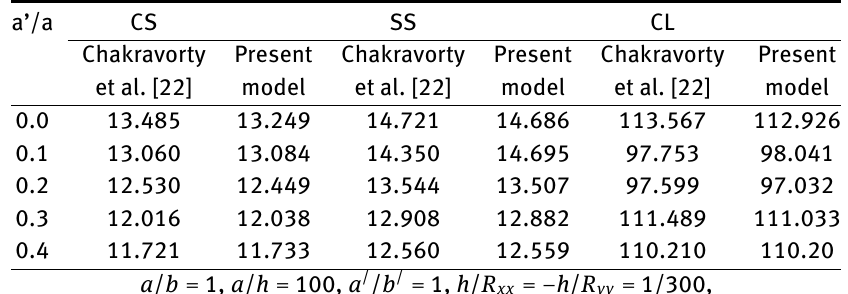
Table 2: Non-dimensional Fundamental Frequencies ( ω ) for laminated composite saddle shell with cutout.